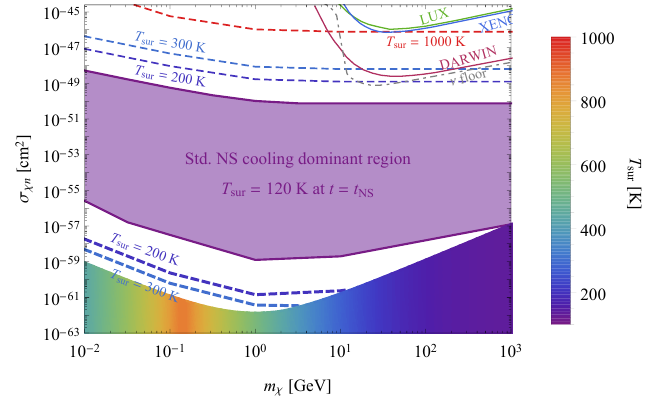
Figure 4 . The purple shaded area is where standard NS cooling overwhelms the DM heating. The corresponding T sur is about 120 K. DM-nucleon interaction and DM self-interaction are responsible for the heating on T sur above and below the purple shaded region in the middle of this (cid:12)gure respectively. We use (cid:27) (cid:31)(cid:31) =m (cid:31) = 4 cm 2 g (cid:0) 1 and h (cid:27)v i = 3 (cid:2) 10 (cid:0) 26 cm 3 s (cid:0) 1 in the calculation. See main text for detail. The constraints on (cid:27) (cid:31)n from di(cid:11)erent DM direct searches such as DARWIN [3], LUX [4] and XENON1T [7] are shown in the plot as